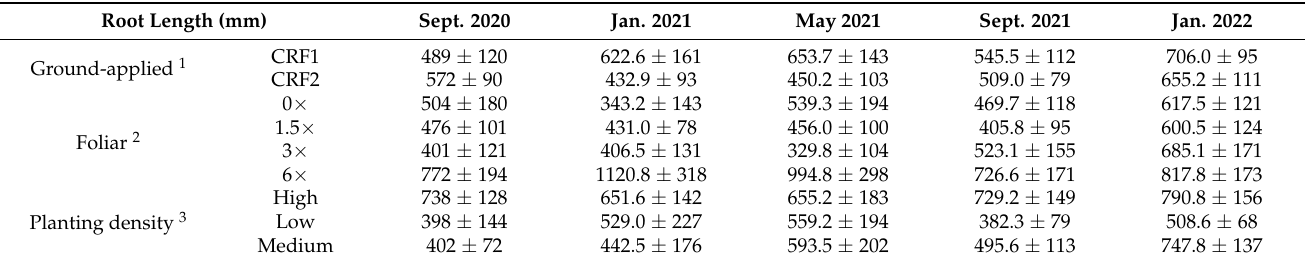
Table 4. Total root length of ‘Ray Ruby’ grapefruit grafted on ‘Kuharske’ citrange planted in flatwood soils located in Fort Pierce, FL, USA, and treated with ground-applied fertilizer, foliar fertilizer and different planting densities from September 2020 to January 2022.